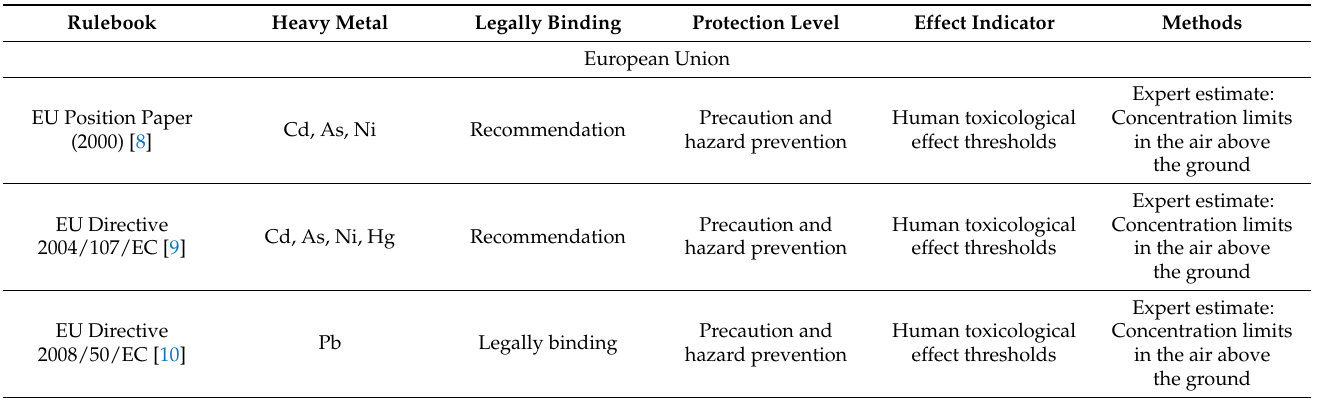
Table 2. Protection levels, protection goals and the impact references for regulations in Western